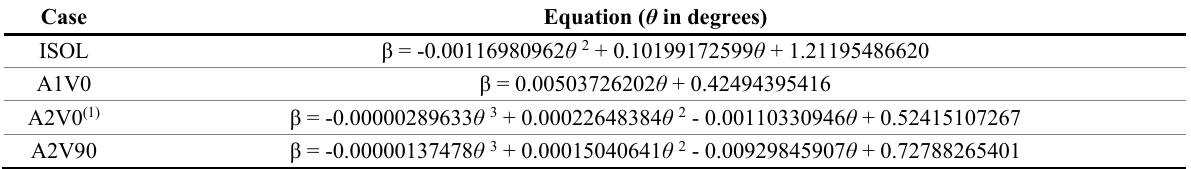
Table 3. Equations of β for acceleration at the top, x-direction – limit criterion of 4.8 cm/s 2 .